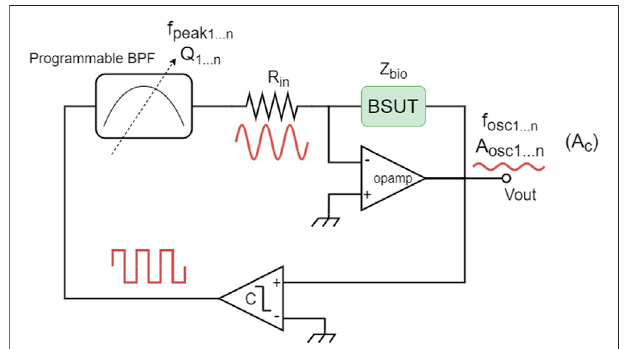
FIGURE 1 | Simpli fi ed schematic for the programmable Oscillation- Based (OB) approach for bioimpedance measurements and spectroscopy